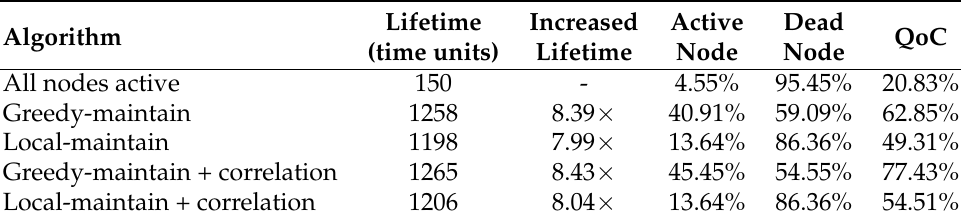
Figure 11. TMON’s percentage of dead nodes over time. Table 7. TMON’s simulation